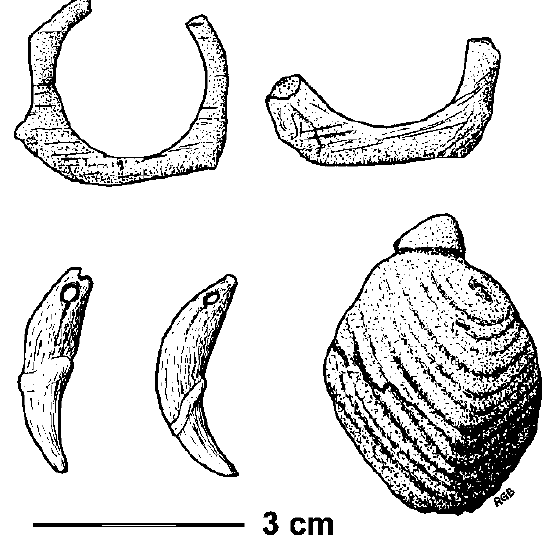
5. Ornaments from Grotte du Renne, Arcy-sur-Cure, France, made by “Neanderthals”: two ivory ring fragments, two perforated animal canines, and a fossil shell with an artificial groove for